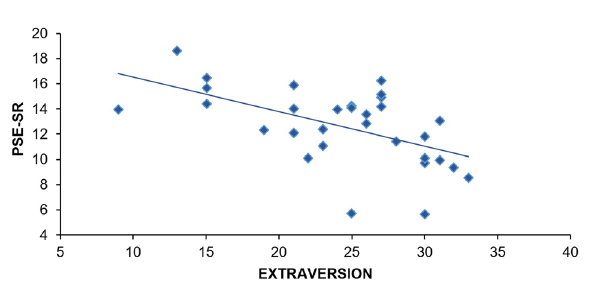
Table 1. Spearman correlation coefficients for PSE-SR and personality factors, and among personality factors for Experiment 1. PSE-SR is the quantity of rolls for which the participant considered the use of the SR and their hands as equivalent. 95% CI is the confidence interval. Significance levels are indicated as follows: * p < .05, ** p < .01, *** p < .001.